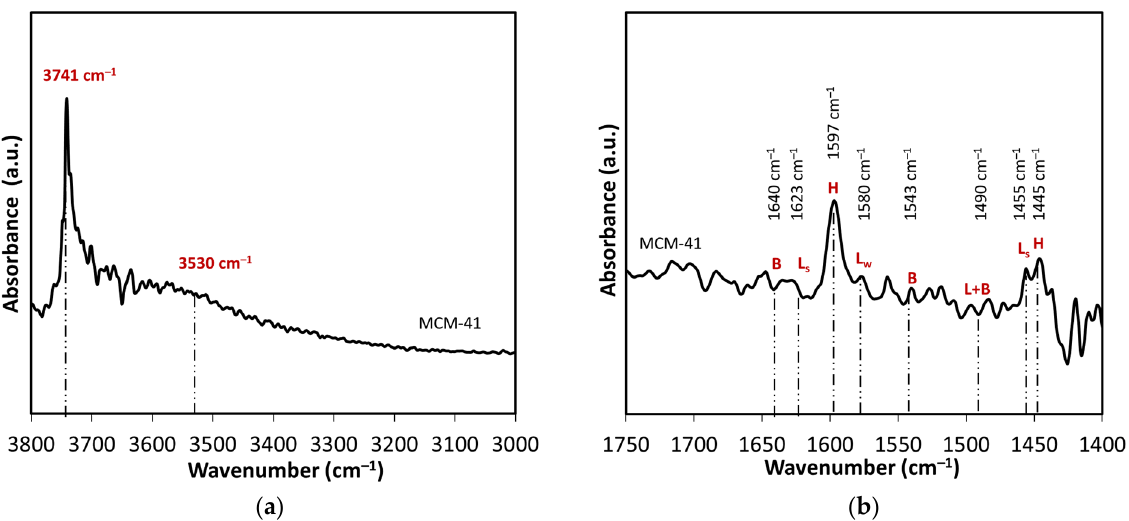
Figure 2. FTIR spectra of MCM-41 catalyst at 100°C of ( a ) hydroxy region, and ( b ) pyridine adsorption.